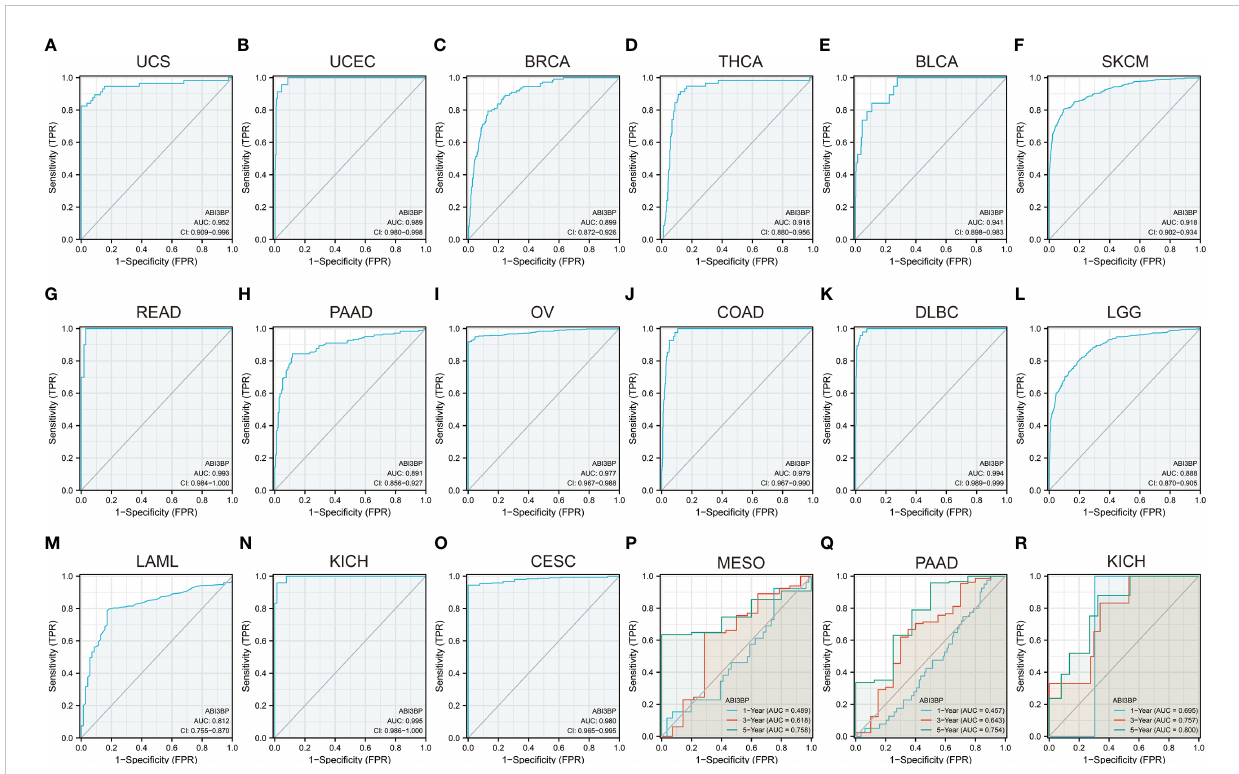
FIGURE 4 Diagnostic and prognostic value of ABI3BP in patients. (A-O) ROC curve of ABI3BP for the prognosis of UCS, UCEC, BRCA, THCA, BLCA, SKCM, READ, PAAD, OV, COAD, DLBC, LGG, LAML, KICH, CESC patients. (P-R) Time-dependent ROC analysis of ABI3BP for 1 -, 3 -, and 5-year survival rates in MESO, PAAD, and KICH